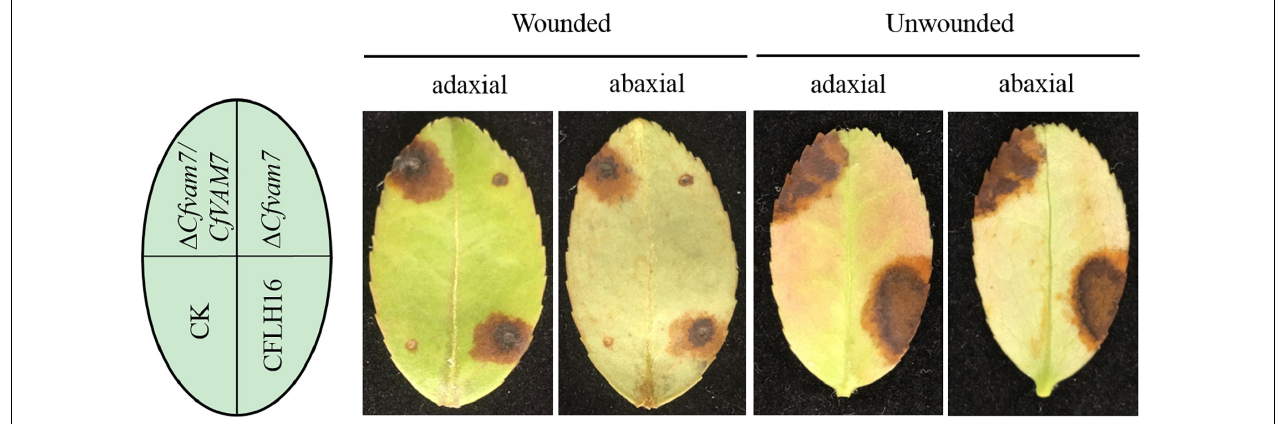
FIGURE 3 | CfVam7 is essential for pathogenicity. Unwounded and wounded tea-oil tree leaves were inoculated with conidium suspensions of wild type (WT), (cid:49) Cfvam7 , and (cid:49) Cfvam7 / CfVAM7 . Up, up of the leaf; Down, down of the leaf; CK: compared with the control, the agar plug or ddH 2 O was inoculated onto